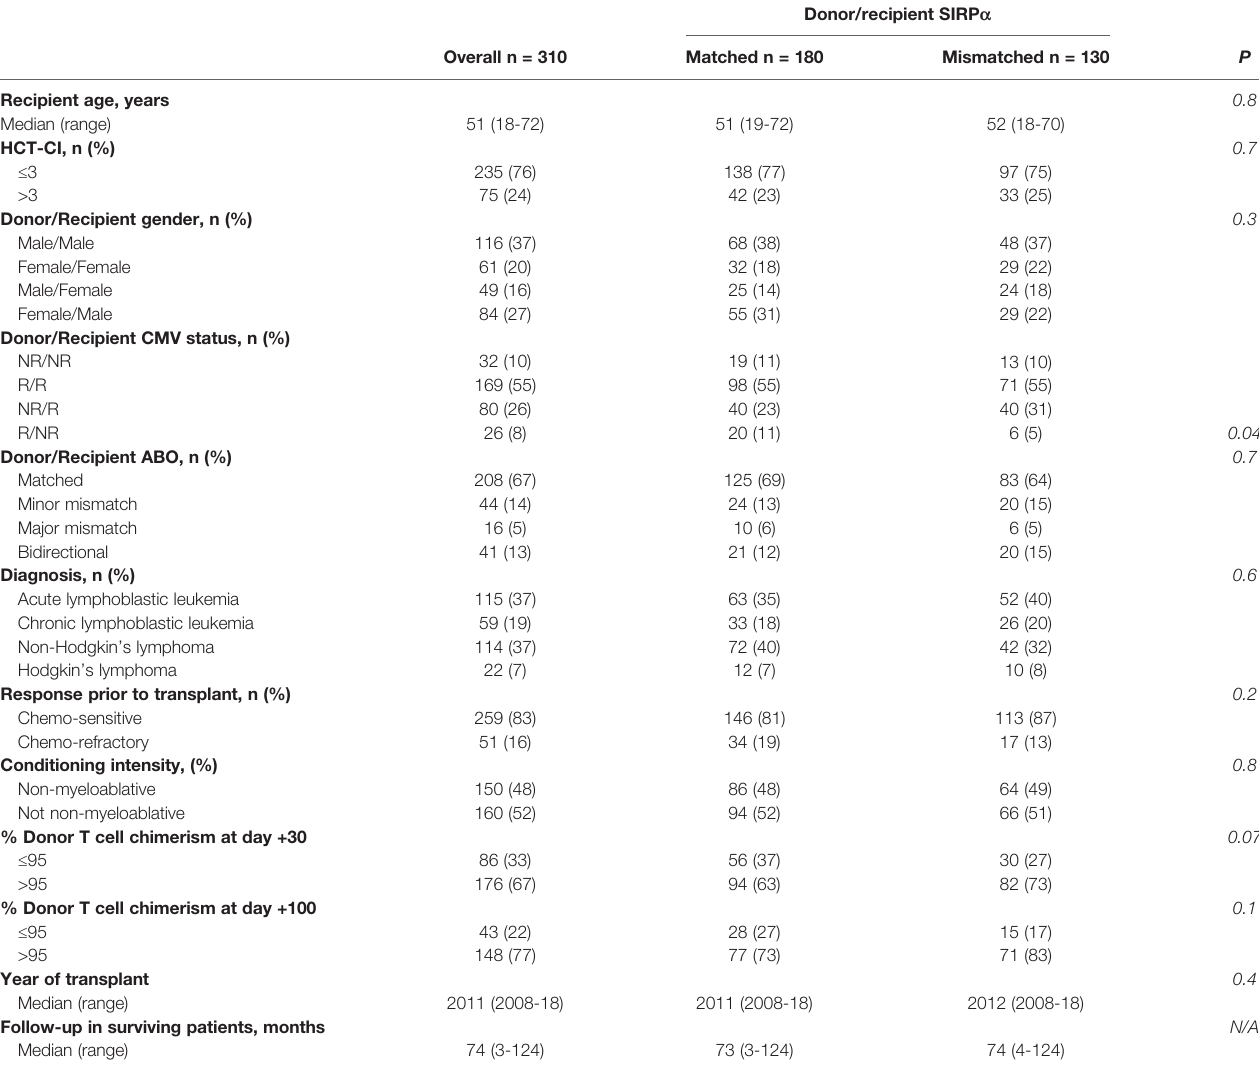
TABLE 1 | Characteristics of the study population overall and according to donor/recipient SIRP a